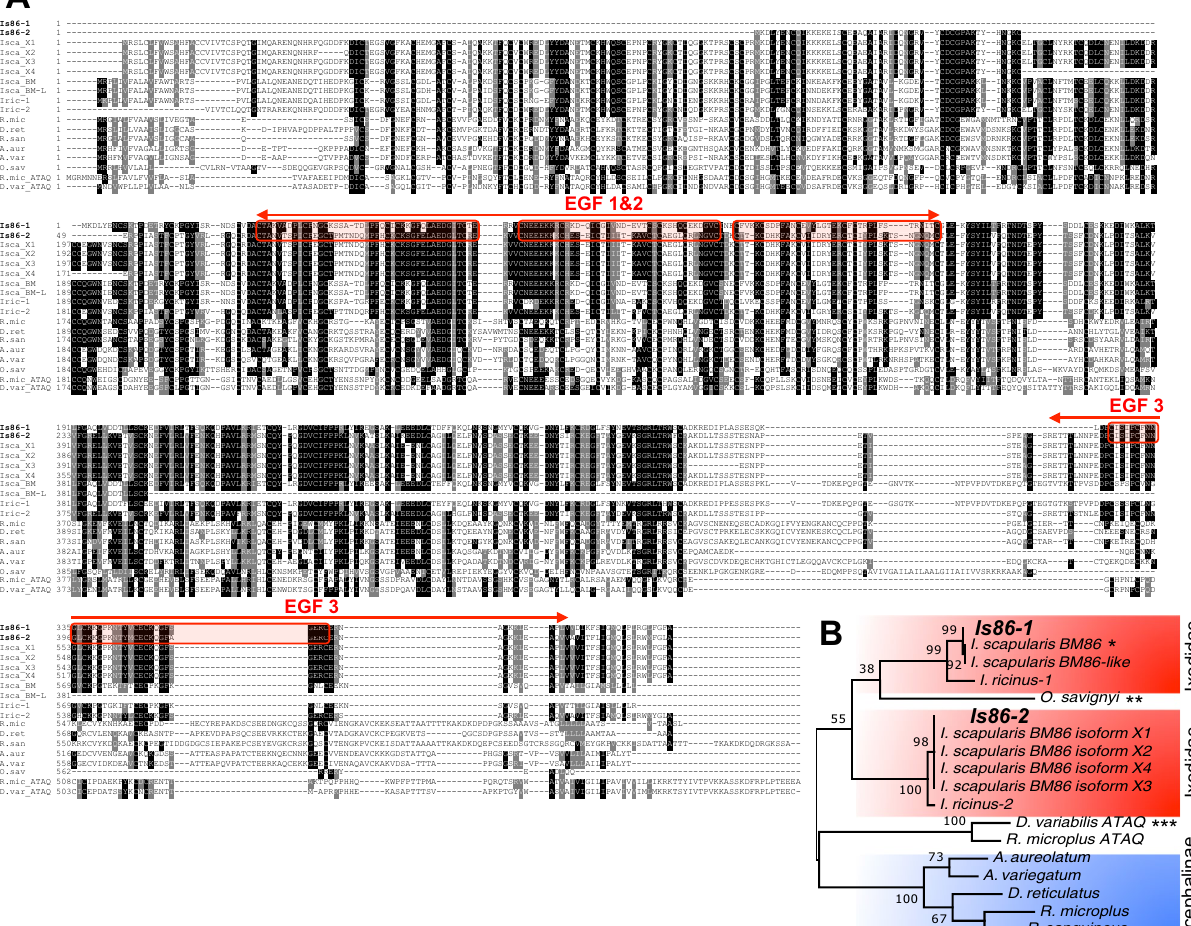
Figure 1. Multiple sequence alignment and phylogeny of Bm86 orthologs. ( A ) Alignment of orthologous Bm86 protein sequences in hard and soft ticks generated in Clustal Omega and BoxShade (https ://www.ch.embne t.org/softw are/BOX_form.html). The letters with a black background are identical amino acids, while gray background letters are similar under the 50% majority rule. Red arrows span the amino acid sequences that were used to generate the recombinant EGF-like domains 1, 2, and 3, as denoted by the red boxes. EGF-1 and EGF-2 are Is86-1 and Is86-2 sequence-specific, respectively, while EGF-3 is sequentially identical for both Is86-1 and Is86-2 . ( B ) Phylogenetic relationship of Bm86 orthologs among hard and soft ticks based on maximum likelihood tree. The numbers by the nodes represent a percent support using 1000 bootstrap replicates. A single asterisk indicates the putative sequences of Is86 recently added to the NCBI GenBank database, two asterisks indicate putative Bm86 orthologs in the soft tick species O. savignyi , and three asterisks denote ATAQ and Bm86 -related